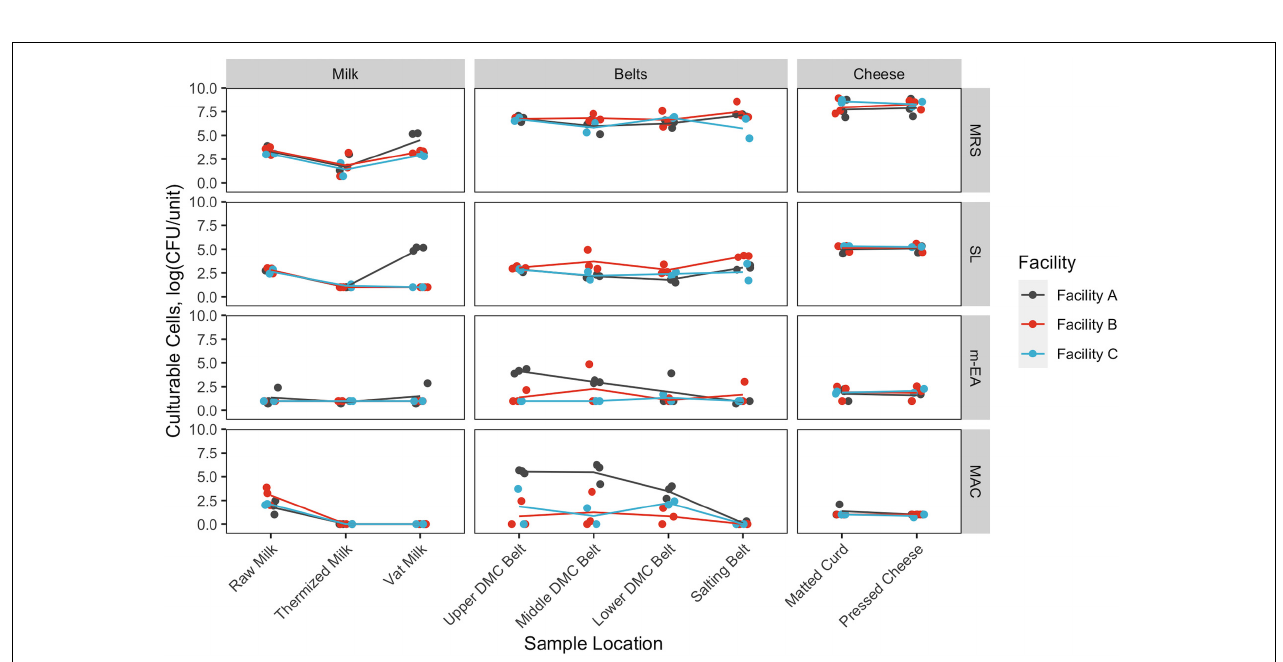
FIGURE 8 | Changes in cell density throughout production. Cell density estimates are based on De Man, Rogosa and Sharpe agar (MRS), Rogosa SL agar (SL), m-Enterococcus agar (m-EA), and MacConkey agar (MAC). Density units vary by sample location: log CFU/mL for milk samples, log CFU/swab for belt samples, and log CFU/g for cheese samples. Samples are colored by facility. Points represent individual samples. Lines represent facility averages.